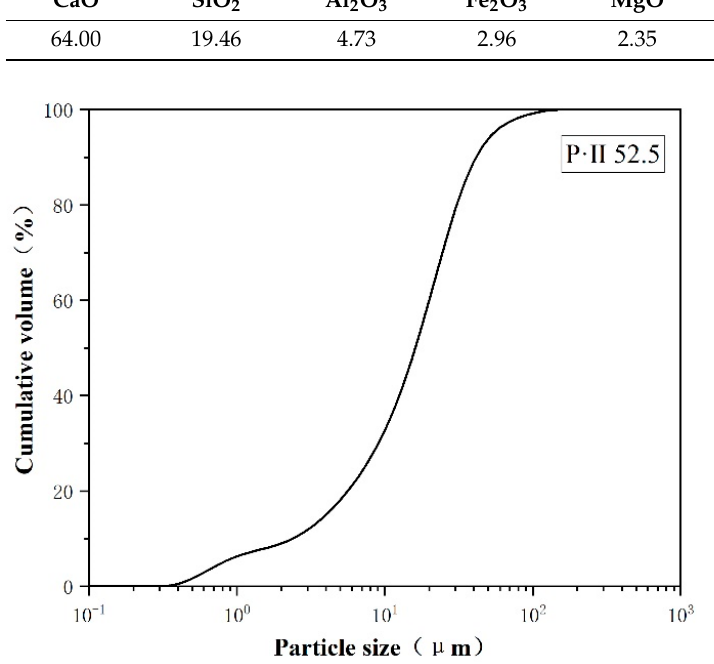
Figure 2. Particle size of P · II 52.5 Portland cement.